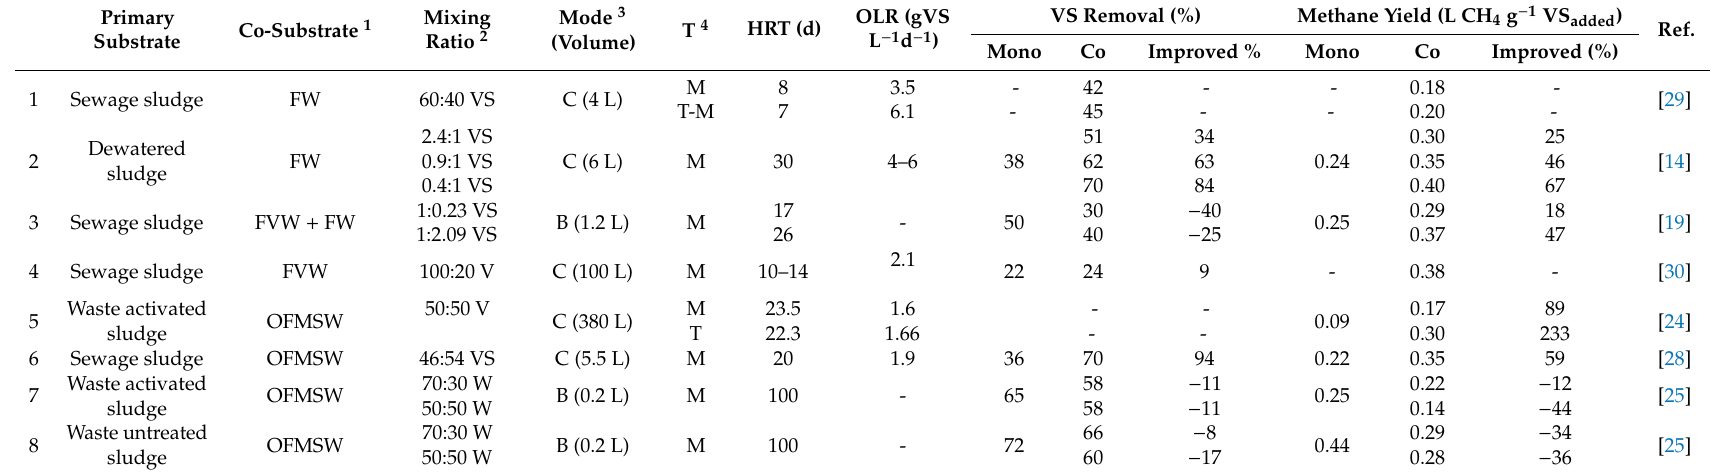
Table 2. Summary of studies utilizing FW, FVW or OFMSW as co-substrate in anaerobic co-digestion of wastewater